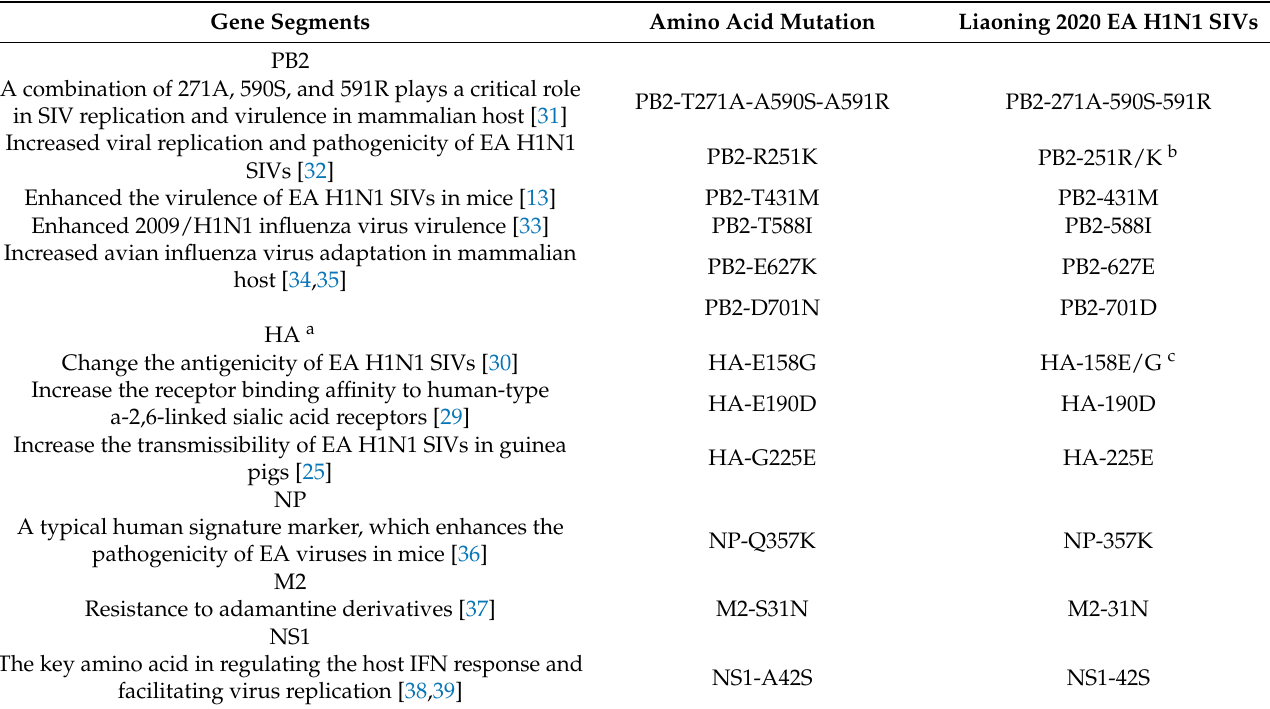
Table 2. Functional amino acid mutations found in Liaoning EA H1N1